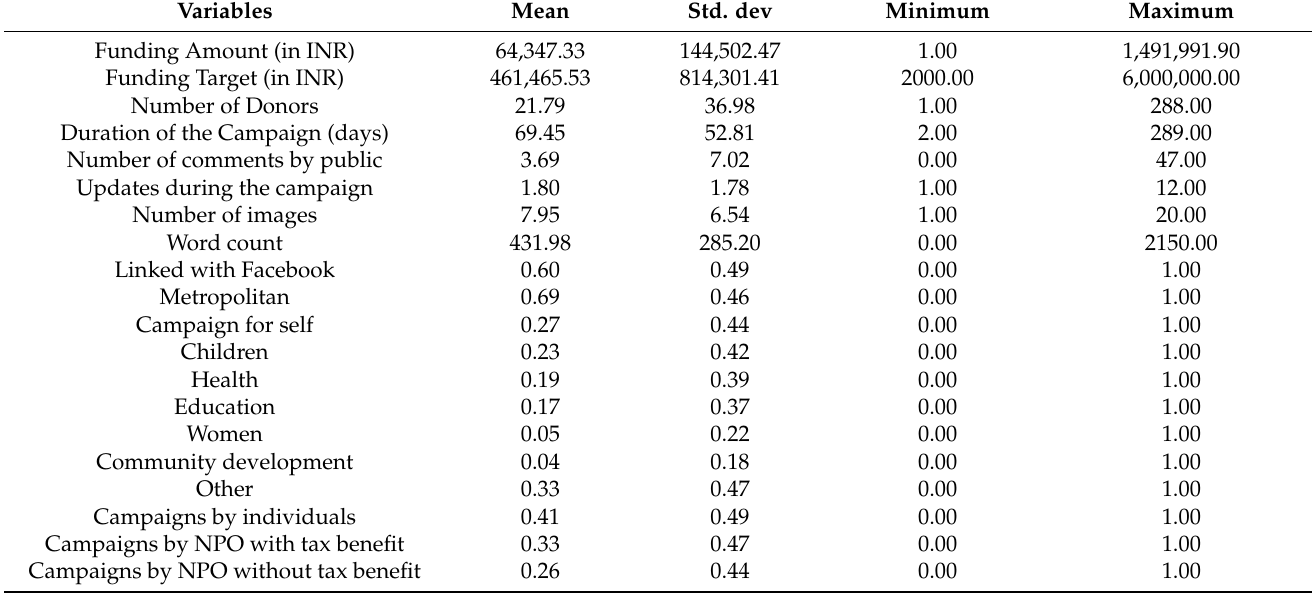
Table 2. Descriptive statistics ( n =